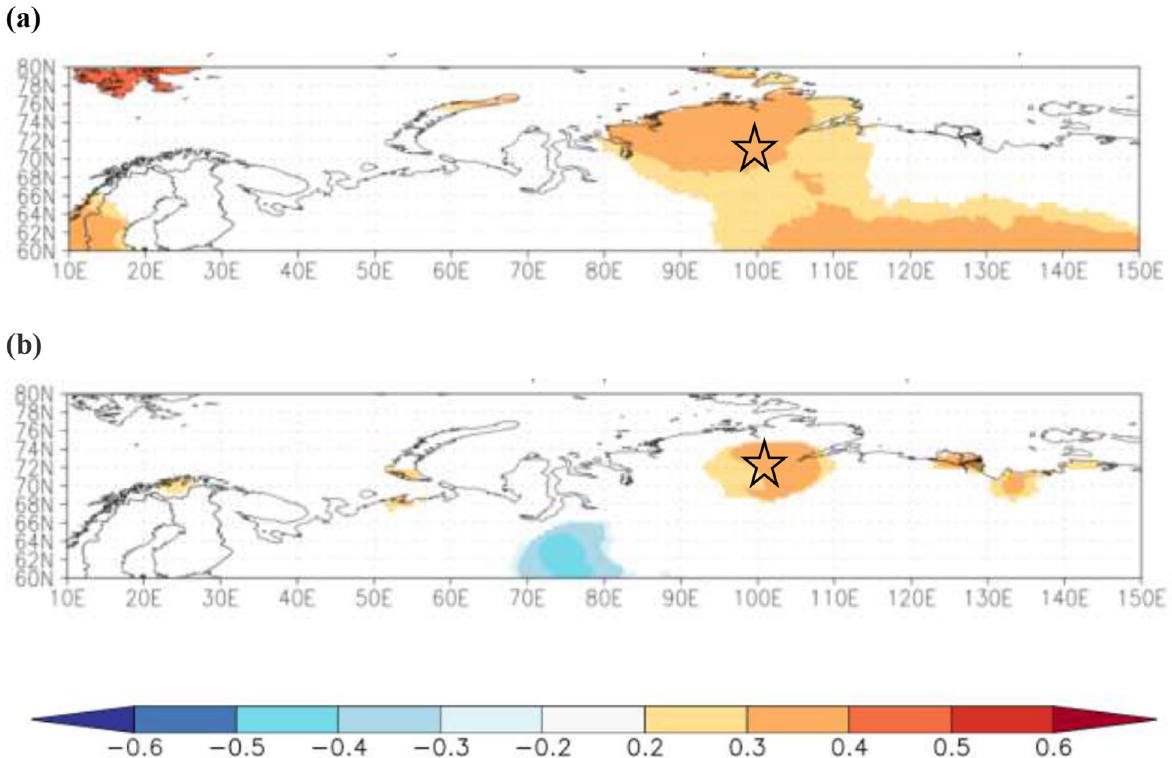
Figure 5. Spatial correlation coefficients computed between ( a ) reconstructed Arctic Oscillation (AO) indexes in May vs. CRU TS4.04 ( P < 0.01) averaged May–July air temperature and ( b ) reconstructed July precipitation vs. CRU TS4.04 ( P < 0.01) gridded July precipitation computed for the period 1969–2009 CE ( P < 0.1) within the 60°–80° N, 10°–150° E. Scale represents a range from negative (− 0.6, blue color) to positive (0.6, red color) values. Star indicates the study site at the Taimyr Peninsula (70° N, 102° E). Climate explorer (KNMI climexp. knmi.nl) was used for plotting a grid net 0.5° within 60°–80° N and 10°–150°